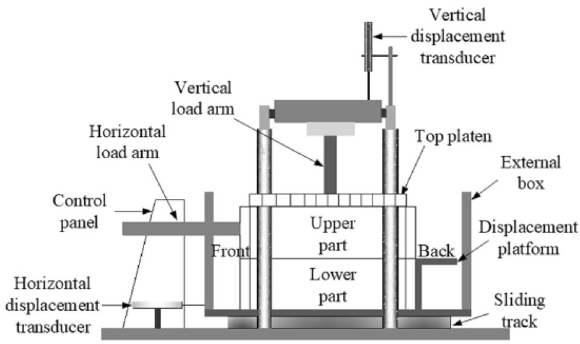
Figure 4. Schematic illustration of the direct shear test apparatus.